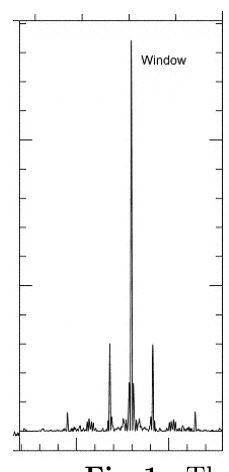
Fig. 1. The Fourier Transform Window for the entire WET light curve of CR Boo in XCov01 (from Fig. 2 of Provencal et al. 1997). The x-ticks are 10 µ Hz and the y-axis shows